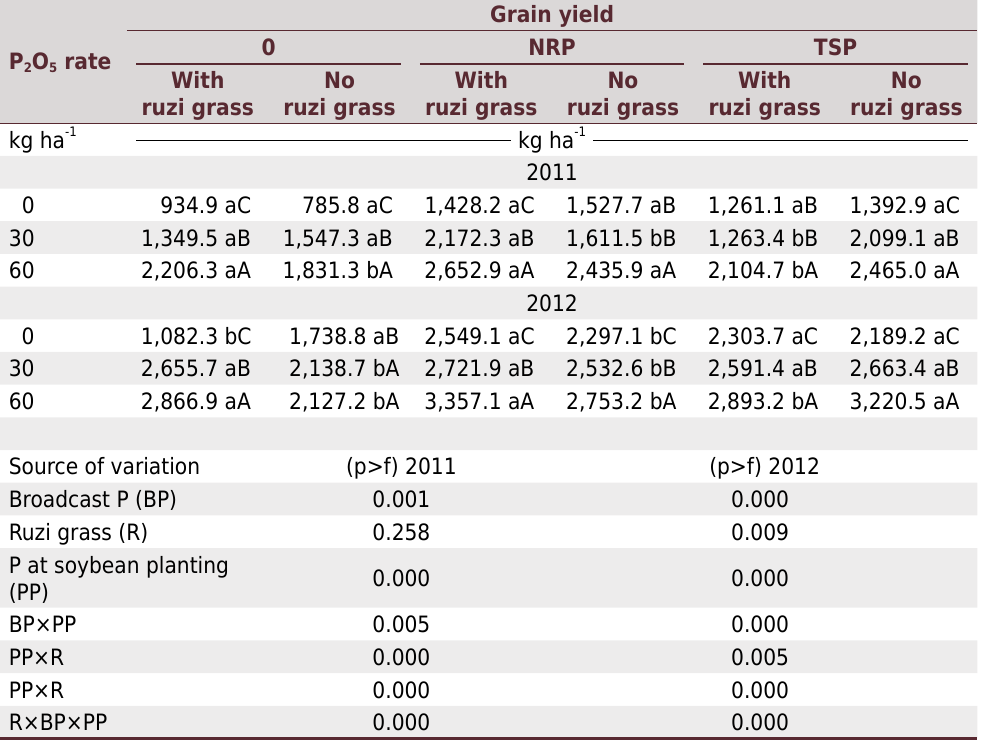
Table 4. Soybean grain yields and P values (p>f) as affected by phosphate fertilizers (soluble and reactive) broadcast in the presence and absence of ruzi grass and P rates applied to soybean seed furrows (0, 30, and 60 kg ha -1 of P 2 O 5 in the form of TSP)